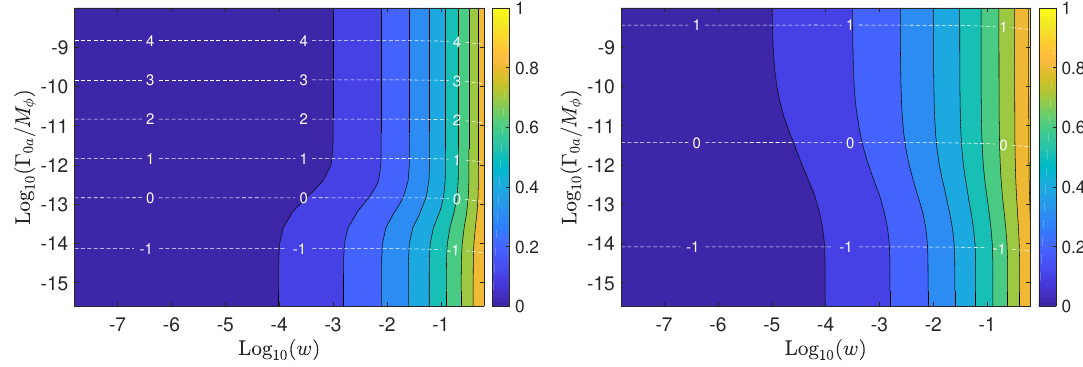
Figure 3. Contours of the post-reheating temperature ratio in the absence of in(cid:13)aton-mediated scattering x rh , as a function of (cid:0) 0 ;a and w = (cid:0) 0 ;b = (cid:0) 0 ;a for the case when in(cid:13)aton is coupled to bosons in both sectors (left) and when it is coupled to fermions in both sectors (right). Other parameters are as speci(cid:12)ed in eq. (3.3). The yellow region corresponds to near-equal temperatures, x (cid:21) 0 : 9, whereas the blue region corresponds to a (cid:12)nal temperature ratio x (cid:20) 0 : 1. The white dashed lines are contours of log ( T rh =M (cid:30) 10